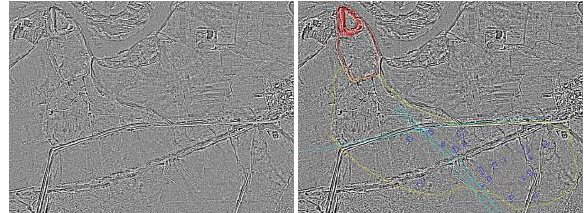
Figure 15a, b - A Sobel edge detector used on FORMOSAT-2 image of Makhmúr al-Qadima site with overlaid objects of interest on the left picture